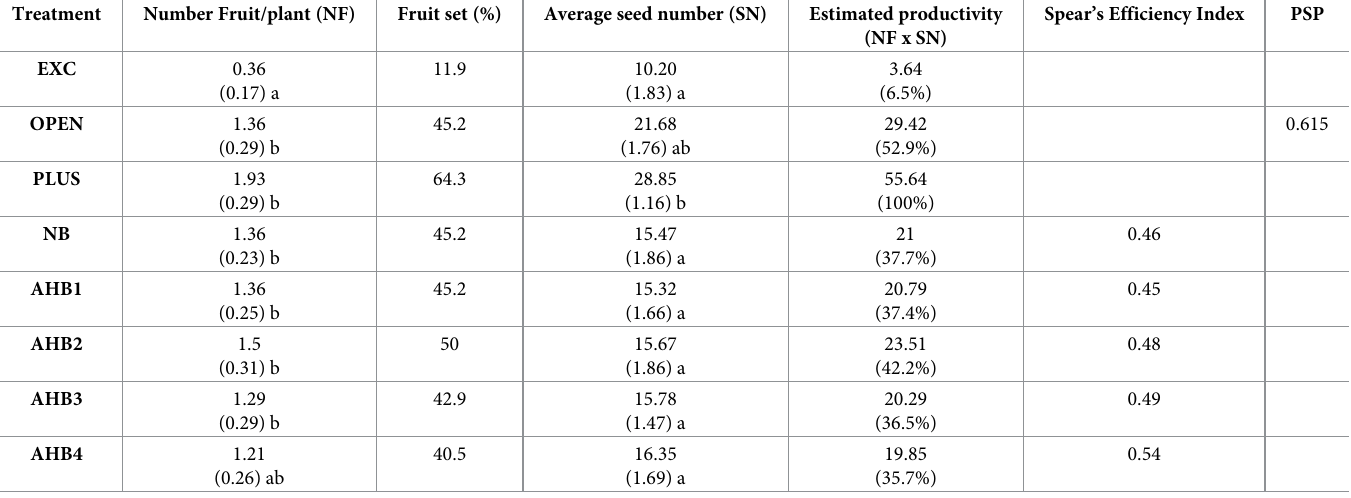
Table 3. Comparison of the average number of fruit and their seed number obtained in eight treatments (see text for acronyms) applied to annatto flowers. Estima- tions of Pollination Efficiency Index at single visits by NB and individual and multiple visits by AHB are also presented, together with estimation of overall Pollination Ser- vice Provision (PSP).